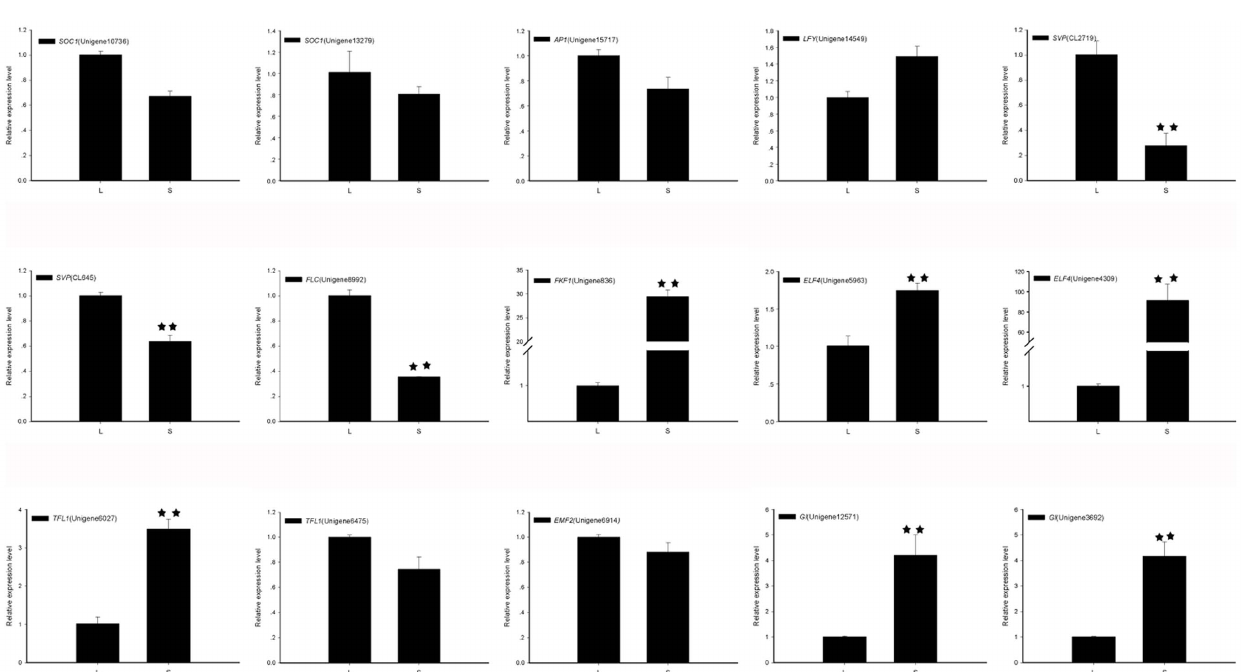
Figure 6. Real-time quantitative RT-PCR confirmation of the differentially expressed genes between ‘Lidongben’ and ‘Sijimi’. Relative transcript levels are calculated by real-time PCR with b -actin as the standard. Data are means ¡ SD of three separate measurements. Duncan’s multiple range test between two samples, ** P #